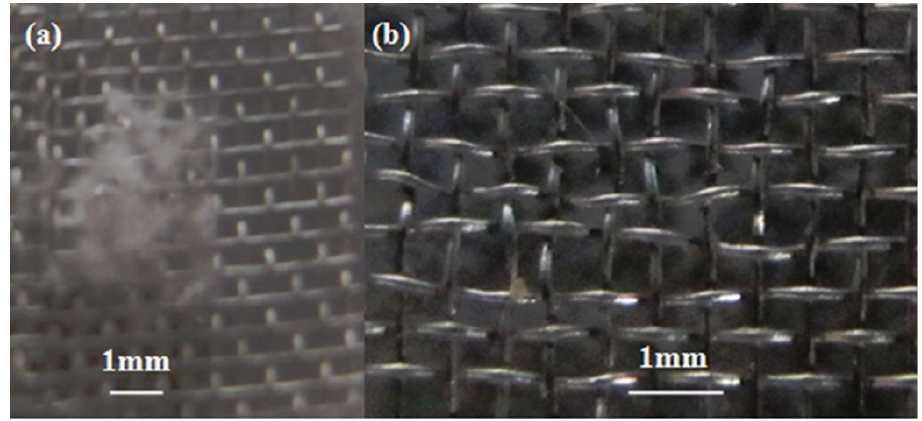
Figure 6. The pictures of PDMS ( a ) and stainless steel net ( b ) after 50 random insertions.